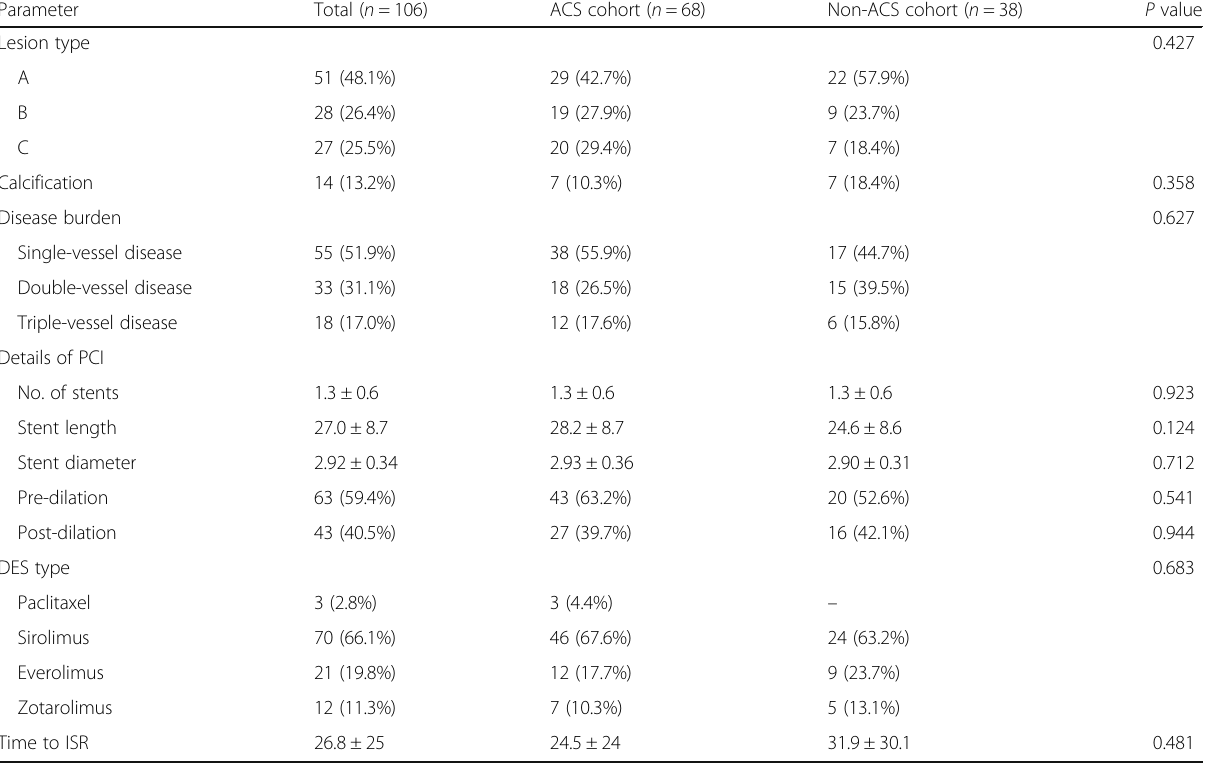
Table 4 Angiographic and PCI characteristics during initial